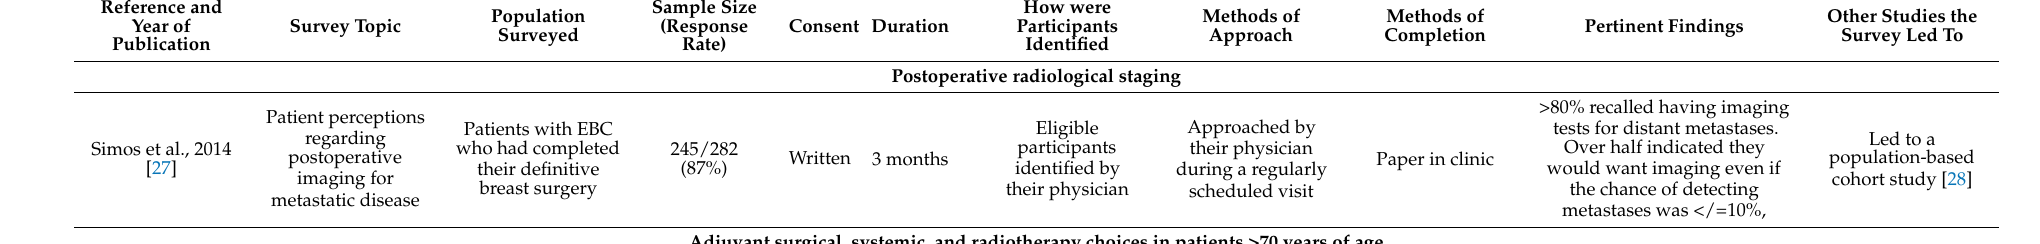
Table 1. Summary of patient